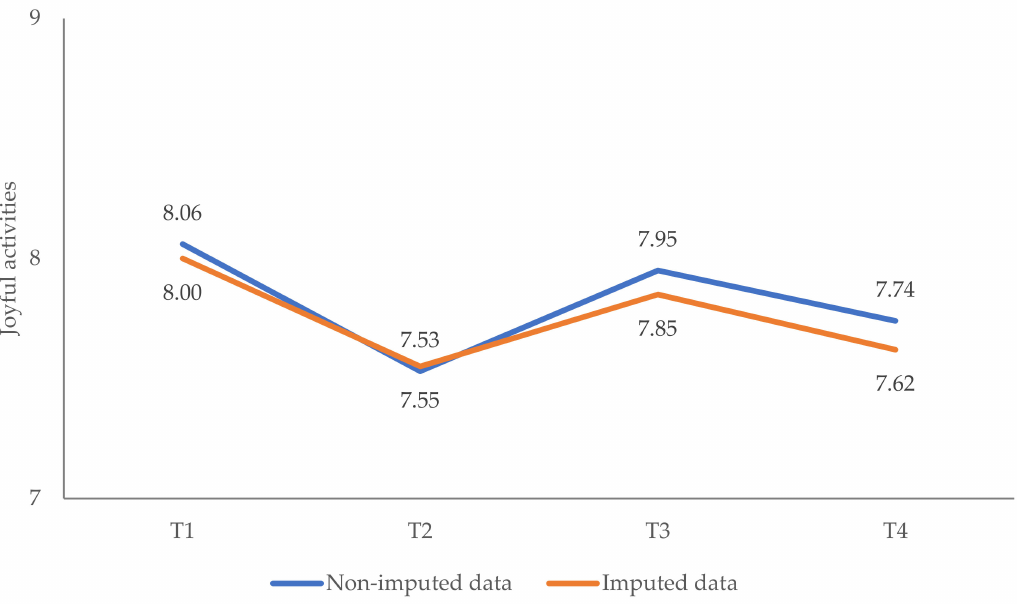
Figure A8. Changes over time in the subscale “Joyful activities”: imputed vs. non-imputed results. Note: Imputed dataset: n = 1001. Non-imputed dataset: n =